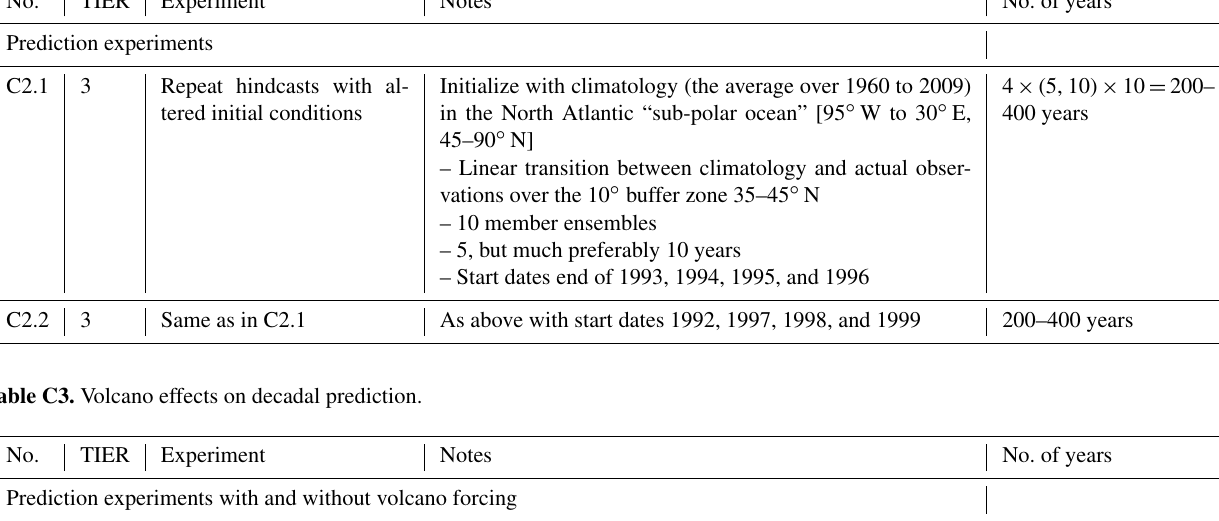
Table C2. Case study of mid-1990s Atlantic subpolar gyre warming. No.